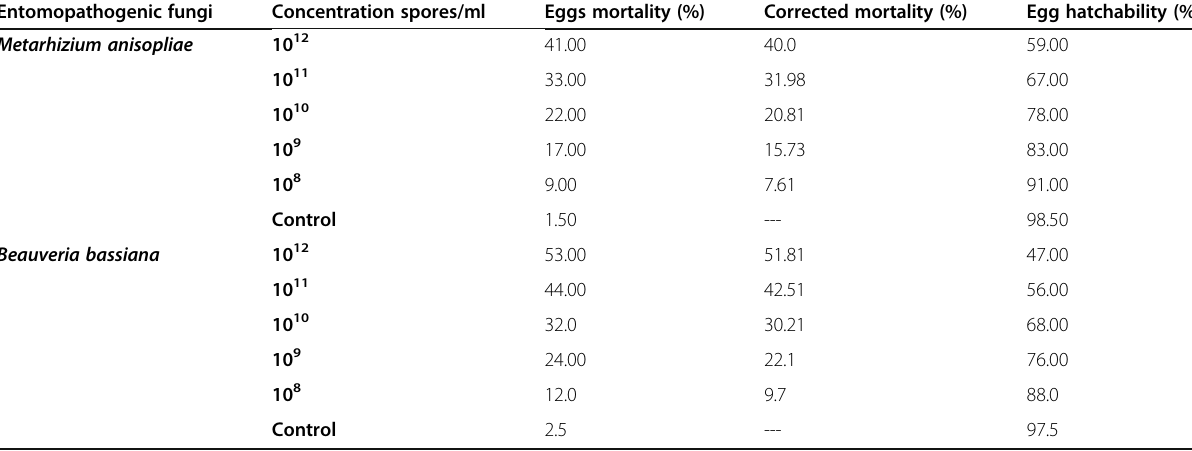
Table 1 Effect of the fungal isolates against the egg stage of Pectinophora gossypiella Entomopathogenic fungi Concentration spores/ml Eggs mortality (%) Corrected mortality (%) Metarhizium anisopliae